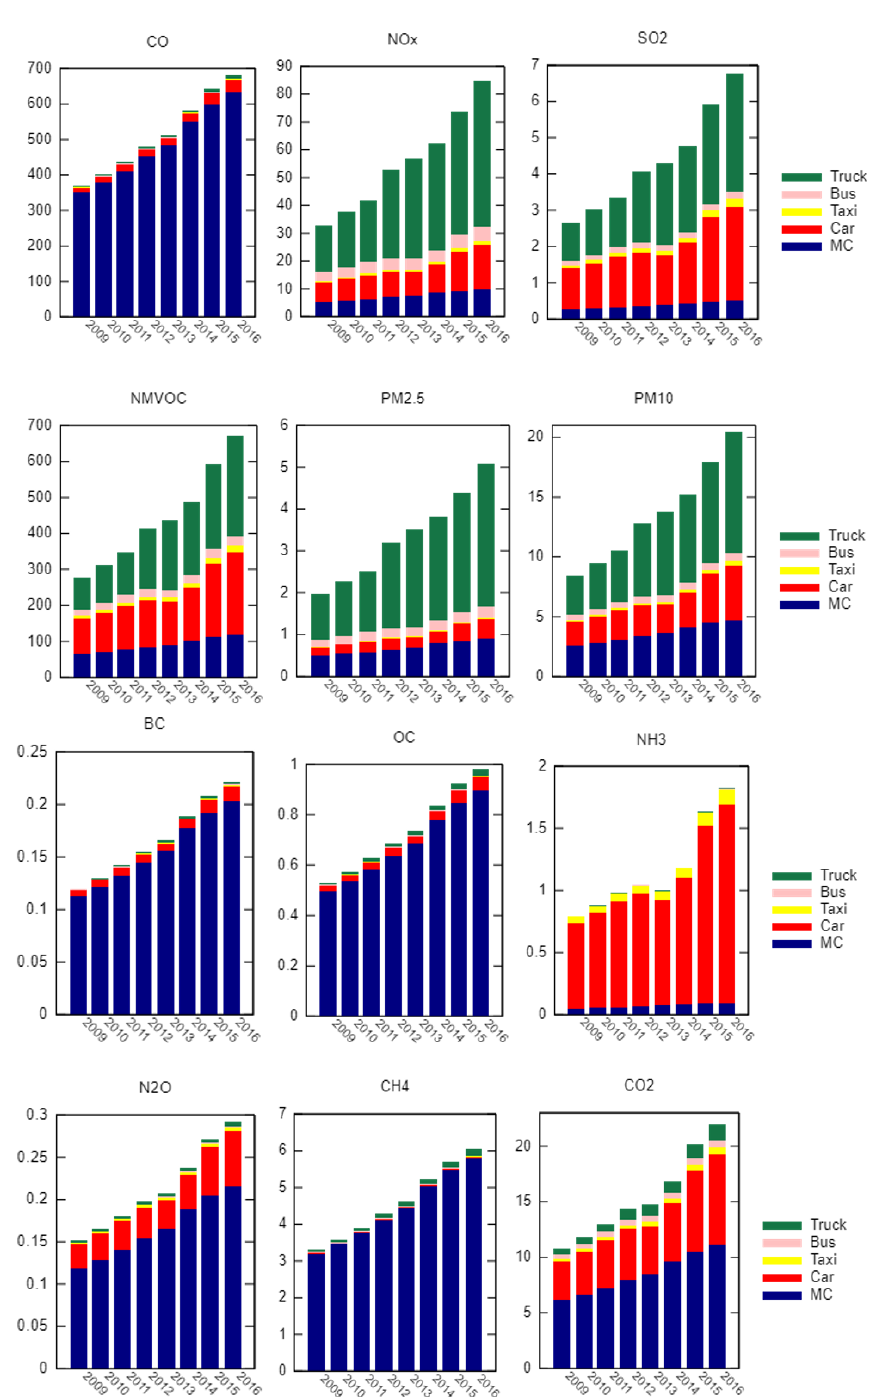
Figure 3. Annual emissions of 12 pollutant species in HCMC from 2009 to 2016 for each vehicle type (unit: Gg).